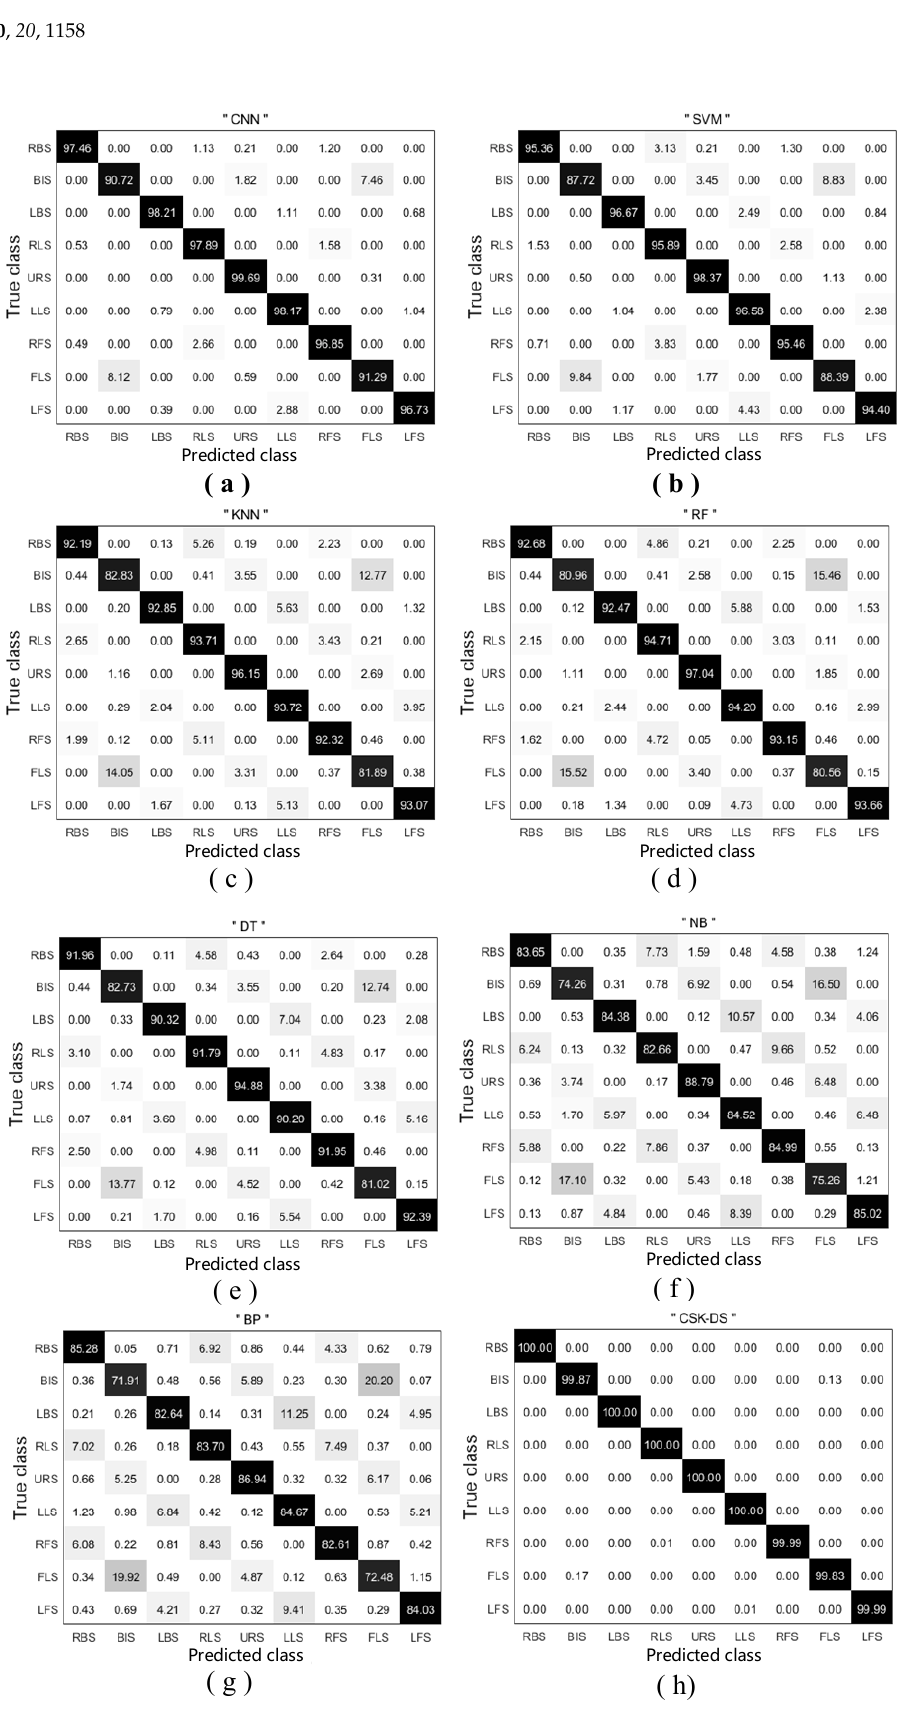
Figure 8. Confusion matrix of each classifier on subject F: ( a ) CNN; ( b ) support vector machine; ( c ) k -nearest neighbor classifier; ( d ) random forest classifier; ( e ) decision tree classifier; ( f ) naive Bayes classifier; ( g ) backpropagation neural network; ( h ) D–S fusion method.